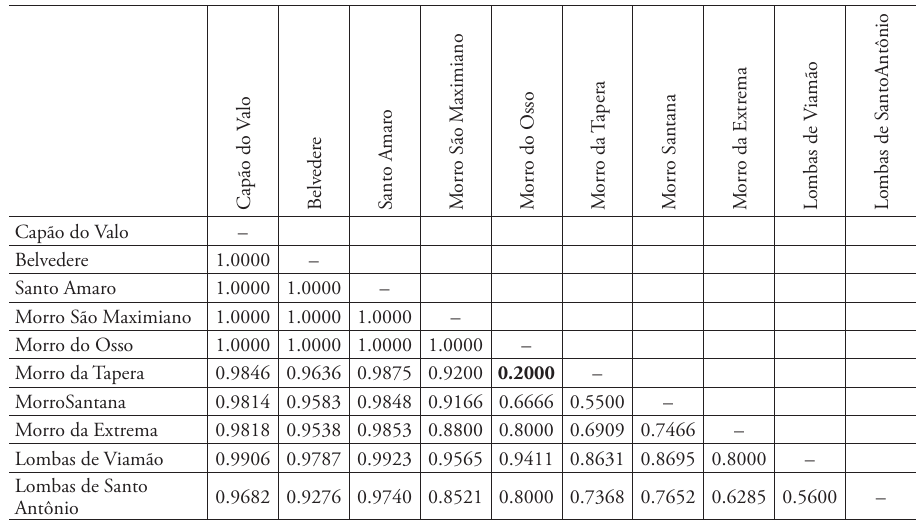
Table 3. Pairwise estimates of gene flow based on φ -statistics ( φ mitochondrial sequences in nine populations C. pampeanus . All comparisons were statistically significant (P < 0.05), except the value in